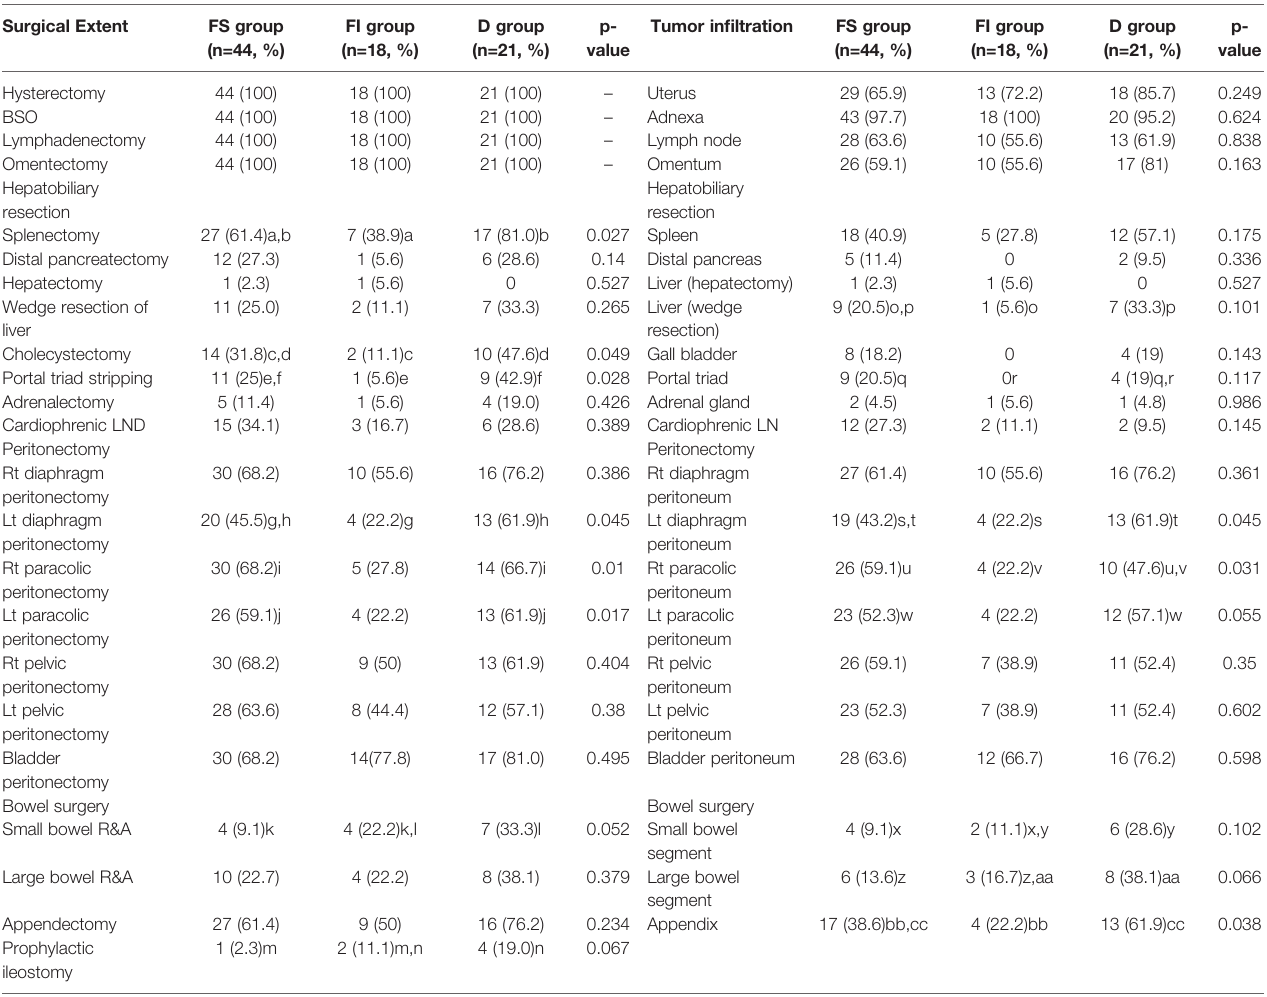
TABLE 2 | Surgical extent and tumor in fi